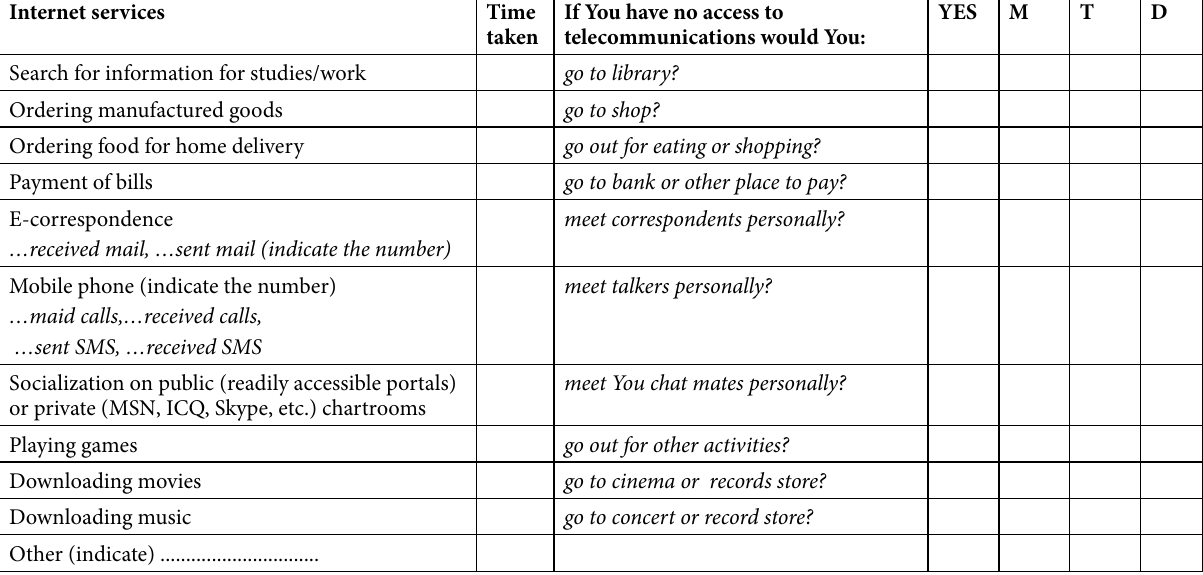
Table 1. Fragment of the diary wording started to be used in 2008 Please indicate the reasons, goals and tasks carried out using telecommunications (Internet and mobile phone) yesterday and time (in minutes) taken for that. Please also point which of your virtual activities would have been replaced with the trip if you have no access to telecommunications (YES column - mark it, if you answer the provided question positively). If you answer that you should replace this activity by the trip, please indicate which transport mode you would use to make that trip (use code from Table 10.a., e.g. taxi – 8 and put into column m,), how long do You think your trip would take (in minutes, put into column T) and approx. distance of the trip (in kilometers km, put into column D